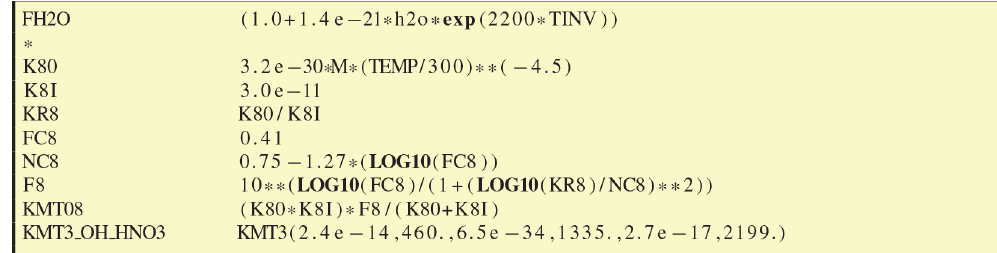
Figure 4. Selected lines from the input file GenIn_Shorthands.txt